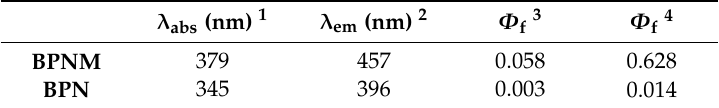
Figure 1. BPNM and BPN response spectra to Zn 2+ . ( a ) Absorption spectra and ( b ) fluorescence spectra of BPN (10 μ M, λ ex = 345 nm) and BPNM (10 μ M, λ ex = 379 nm) with different Zn 2+ concentrations in the mixture of Tris-HCl (10 mM, pH = 7.4) and DMSO ( V : V = 9:1). Table 1. Photophysical properties of BPNM and BPN.